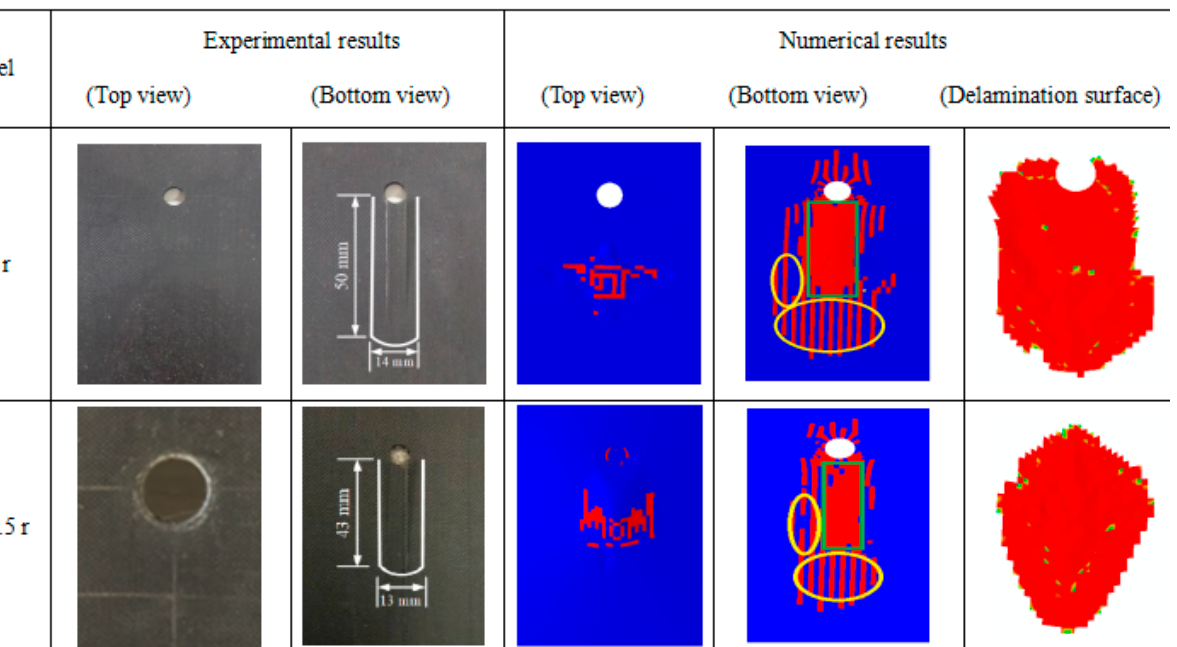
Table 2. Experimental and numerical delamination surface area